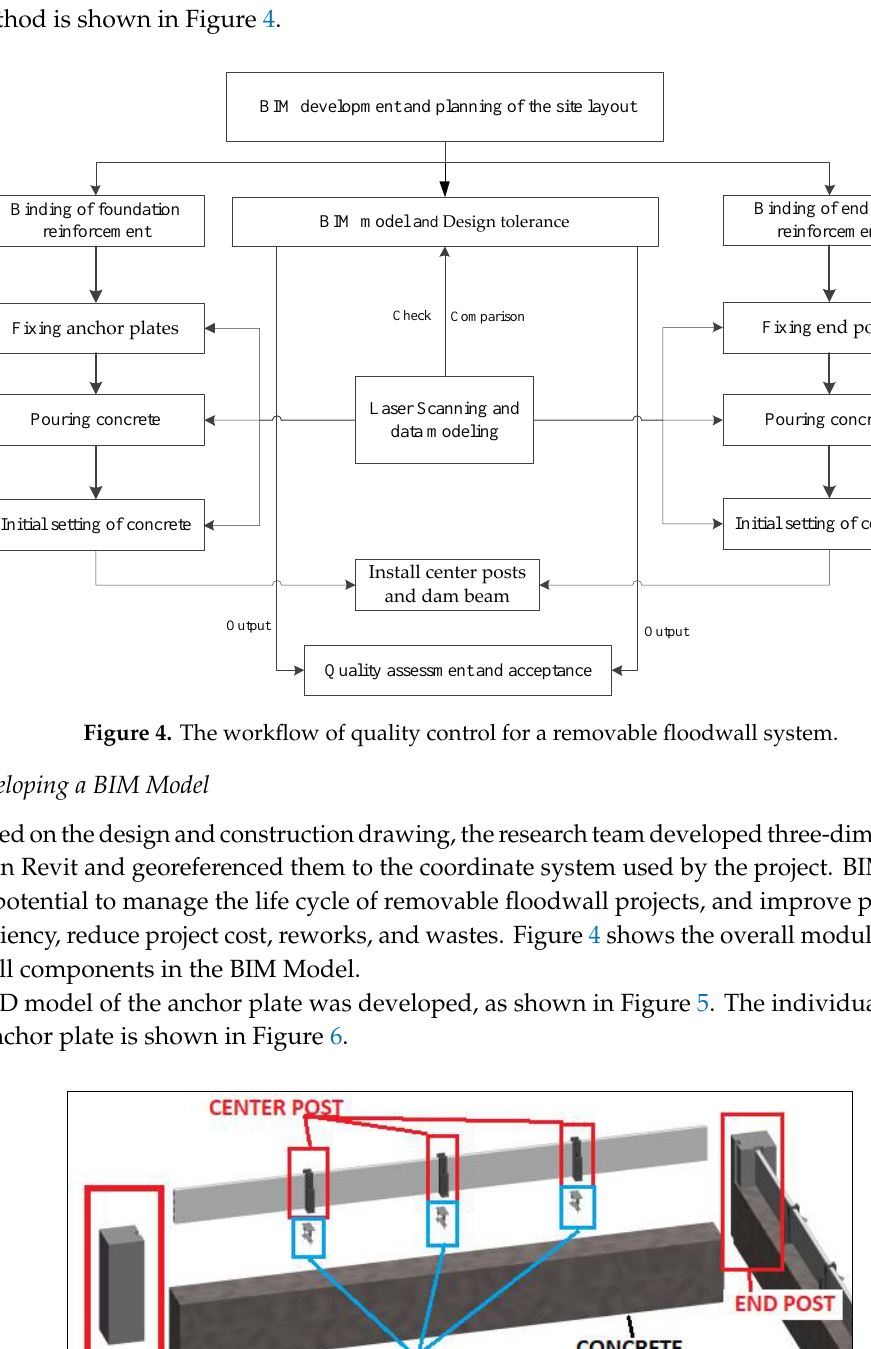
( a ) ( b ) Figure 6. Anchor plate: ( a ) Anchor plate—BIM model, and ( b ) anchor plate—components. ( a ) ( b ) Figure 7. Anchor plates and the reinforcement: ( a ) Installation BIM model before pouring concrete, and ( b ) anchor plates welded to the reinforcement.